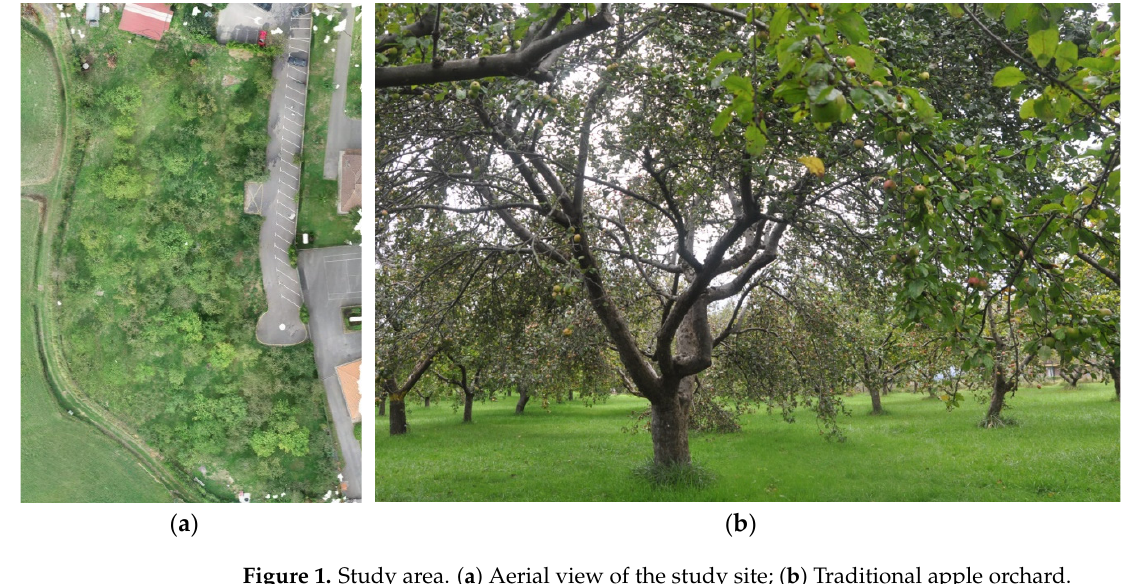
Figure 1. Study area. ( a ) Aerial view of the study site; ( b ) Traditional apple orchard. The surface qualities of the fruit cannot be determined in previous stages of develop- ment, as the colour, shape, texture and size are only fixed at the end of the ripening pro- cess. Therefore, this study was carried out on mature apple specimens collected from the trees (Figure 2). Photographs of the samples were taken in a controlled environment, in lightboxes. Of the 150 available trees, a study was made of the varieties available on this farm, with samples taken in different years, because in one year, the varieties that were in the alternate bearing stage produced apples the following year.